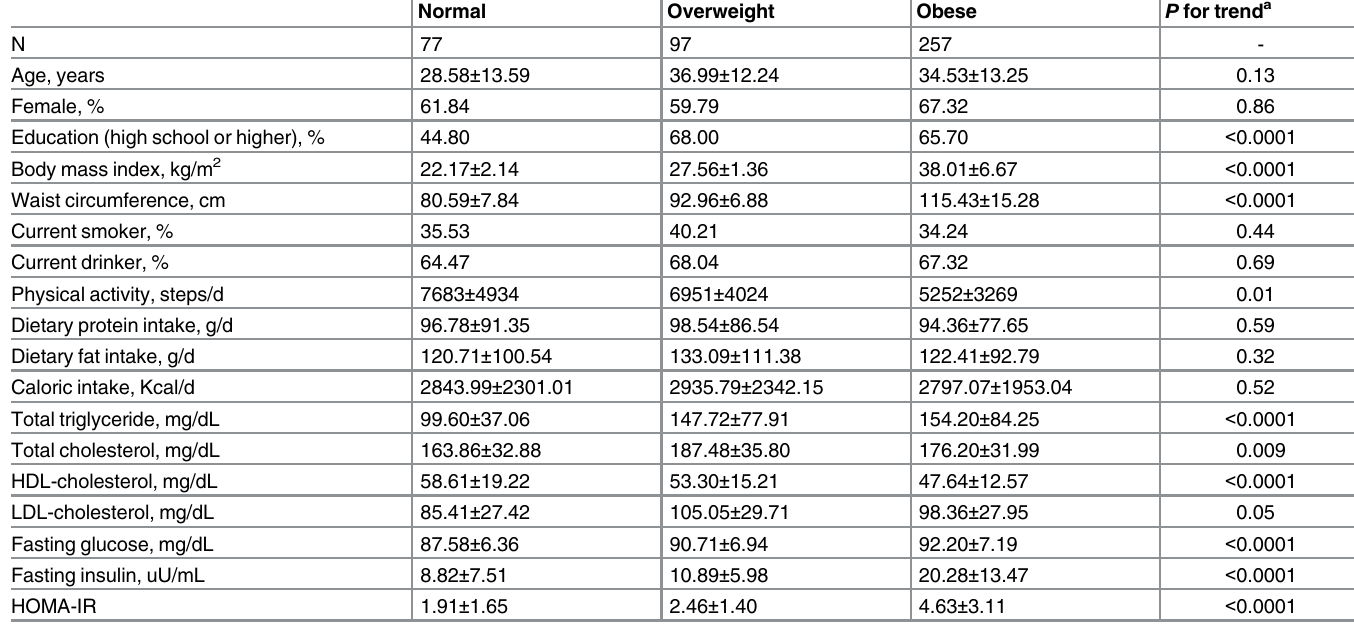
Table 1. Clinical characteristics of the study participants according to obesity (N = 431). Normal Overweight Obese P for trend